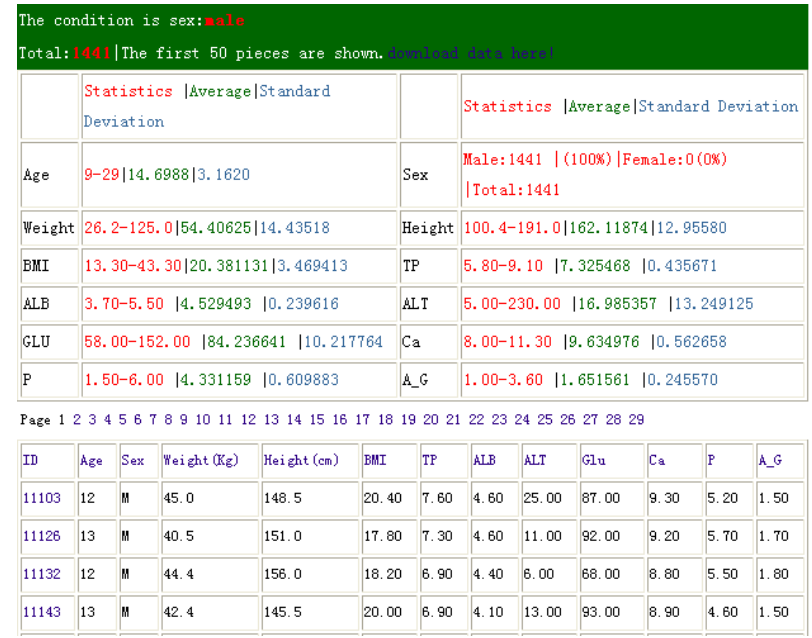
FIGURE 3 . One user’s query